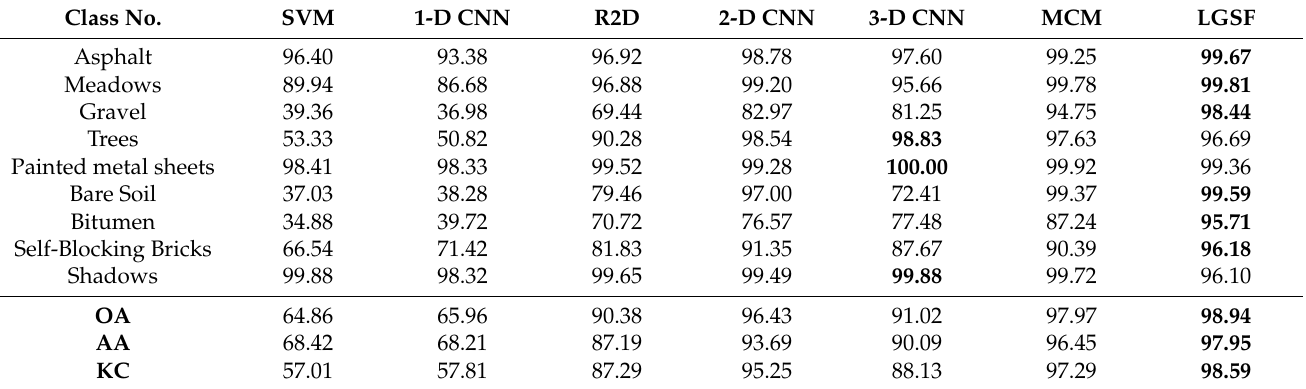
Table 7. Classification results of different methods on the Pavia University dataset. (shown in %).